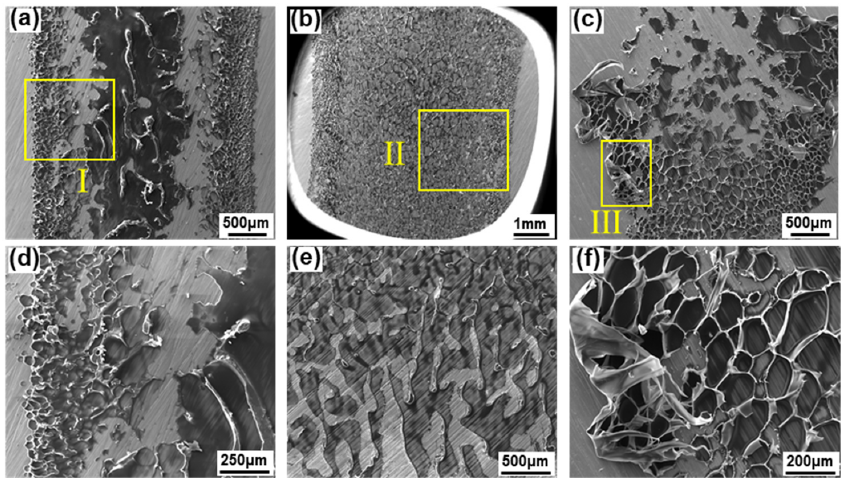
Figure 6. Fracture surfaces at 304SS side of tensile samples: ( a ) LTJ, ( b ) O-LTJ, ( c ) O-LCJ, ( d ) details of region I, ( e ) details of region II, ( f ) details of region III.